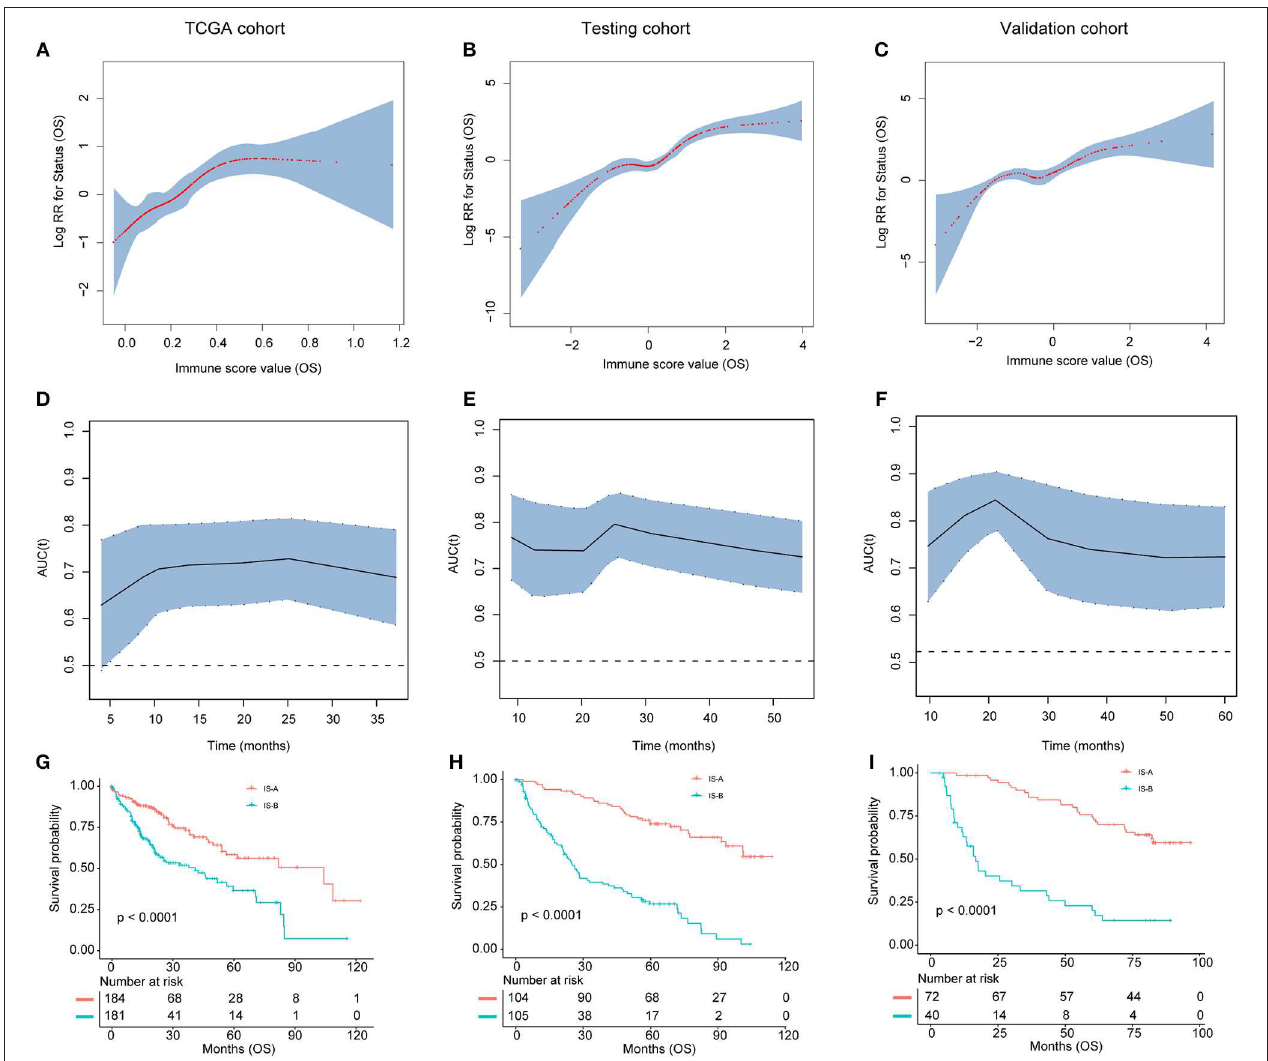
FIGURE 3 | (A–C) The restricted cubic spline of the immune score in TCGA, testing, and validation cohorts (OS). (D–F) . The immune score had acceptable predictive ability in all three cohorts. OS, overall survival; RR, risk ratio; AUC, area under the receiver operating characteristic curve. (G–I) Patients with immune type B (IS-B) had significantly worse overall survival than patients with immune type A (IS-A) in all three